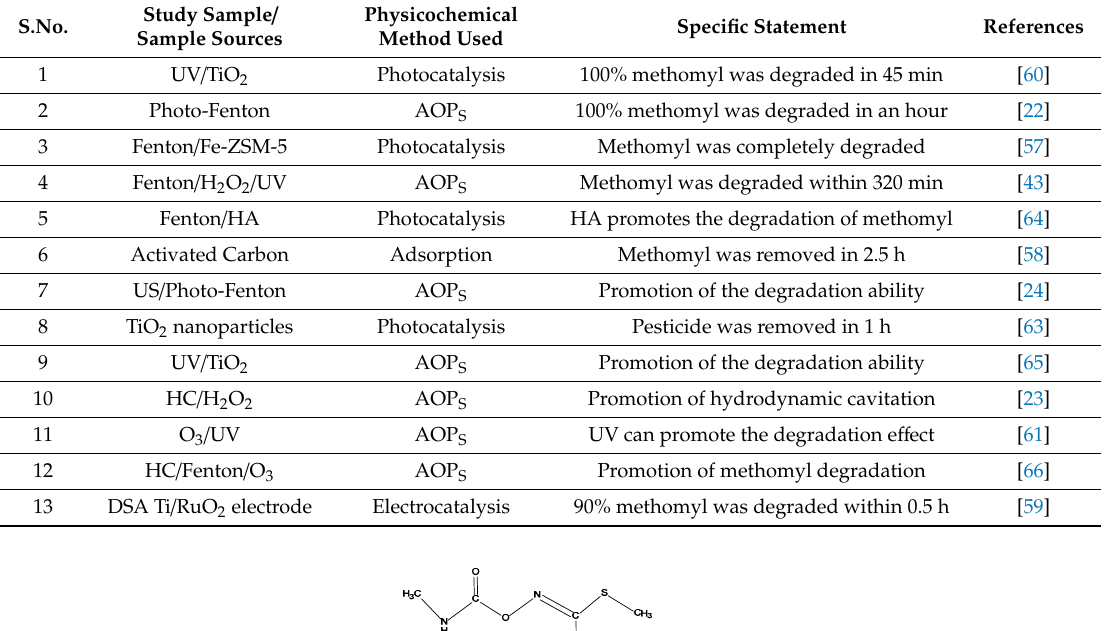
Table 2. Physical and chemical approaches to the removal of methomyl from contaminated environments. S.No.